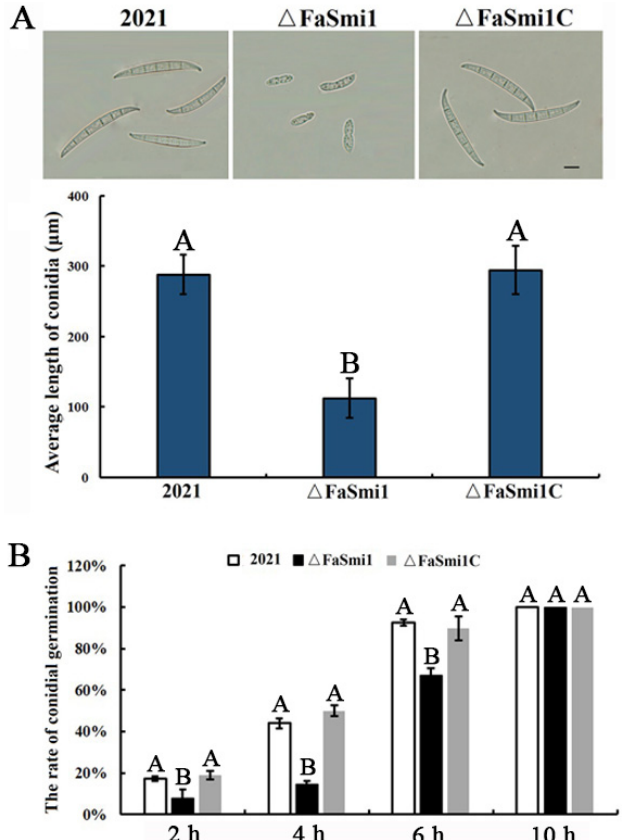
Figure 2. Effects of FaSmi1 deletion on development and germination of conidia in F. asiaticum . ( A ) The conidia were isolated after mycelial plugs of the wild-type strain 2021, FaSmi1 deletion mutant ∆ FaSmi1 and complemented strain ( ∆ FaSmi1C ) were grown on MBB at 25 ◦ C for 7 days. The conidia morphology of each strain was observed. Bar = 12 μ m (up panel), the average length of conidia of each strain was measured. Bars denote standard errors from three experiments (down panel). Values on the bars followed by the same letter are not significantly different at p = 0.05. ( B ) Conidia of each strain were incubated on water–agar media at 25 ◦ C. Conidial germination rates of each strain were measured at 2, 4, 6 and 10 h. Bars denote standard errors from three experiments. Values on the bars followed by the same letter are not significantly different at p =